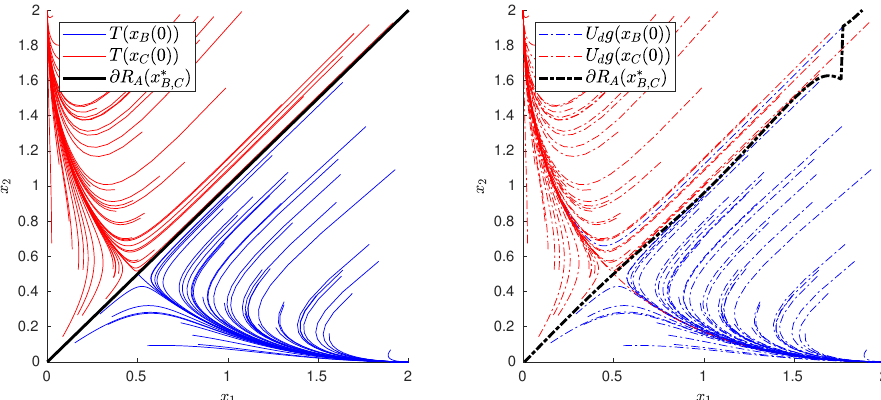
Figure 2. Trajectories and boundary of the asymptotically stable points of ( left ) the system of differential equations and ( right ) the Koopman operator and unitary